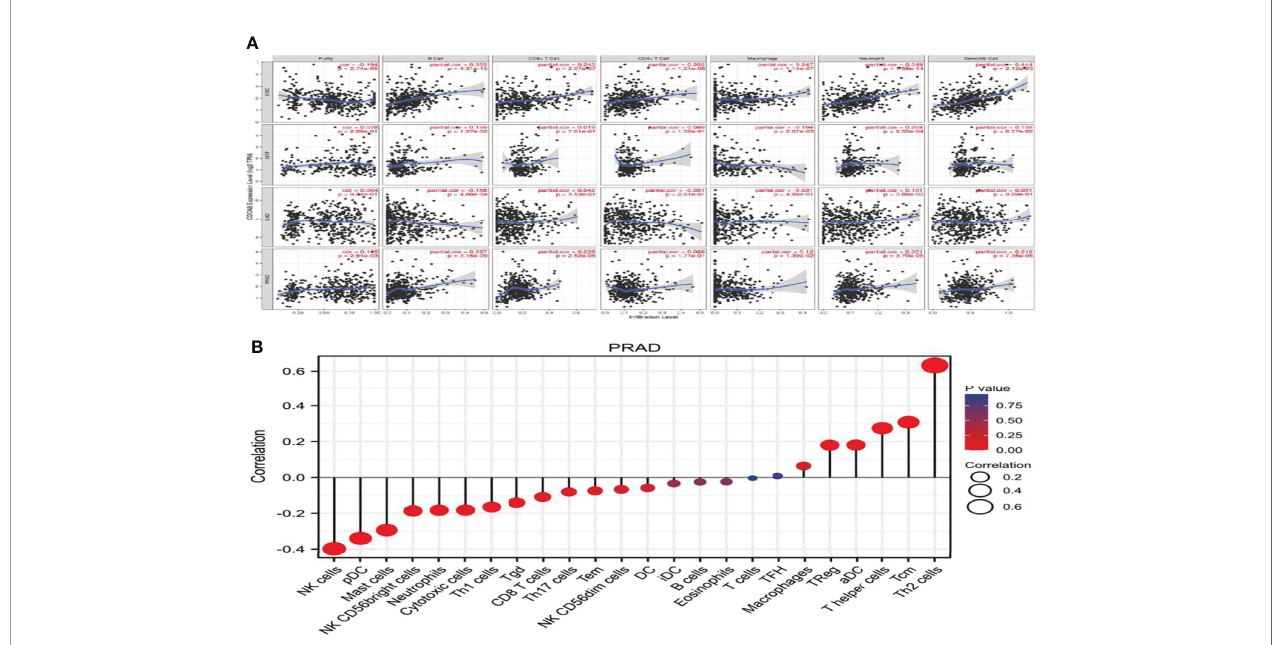
FIGURE 3 | (A) The correlation between PCa, KIRP, KIRC, LUAD, and immune cell in fi ltration. (B) The correlation between PCa and immune factor in fi ltration.